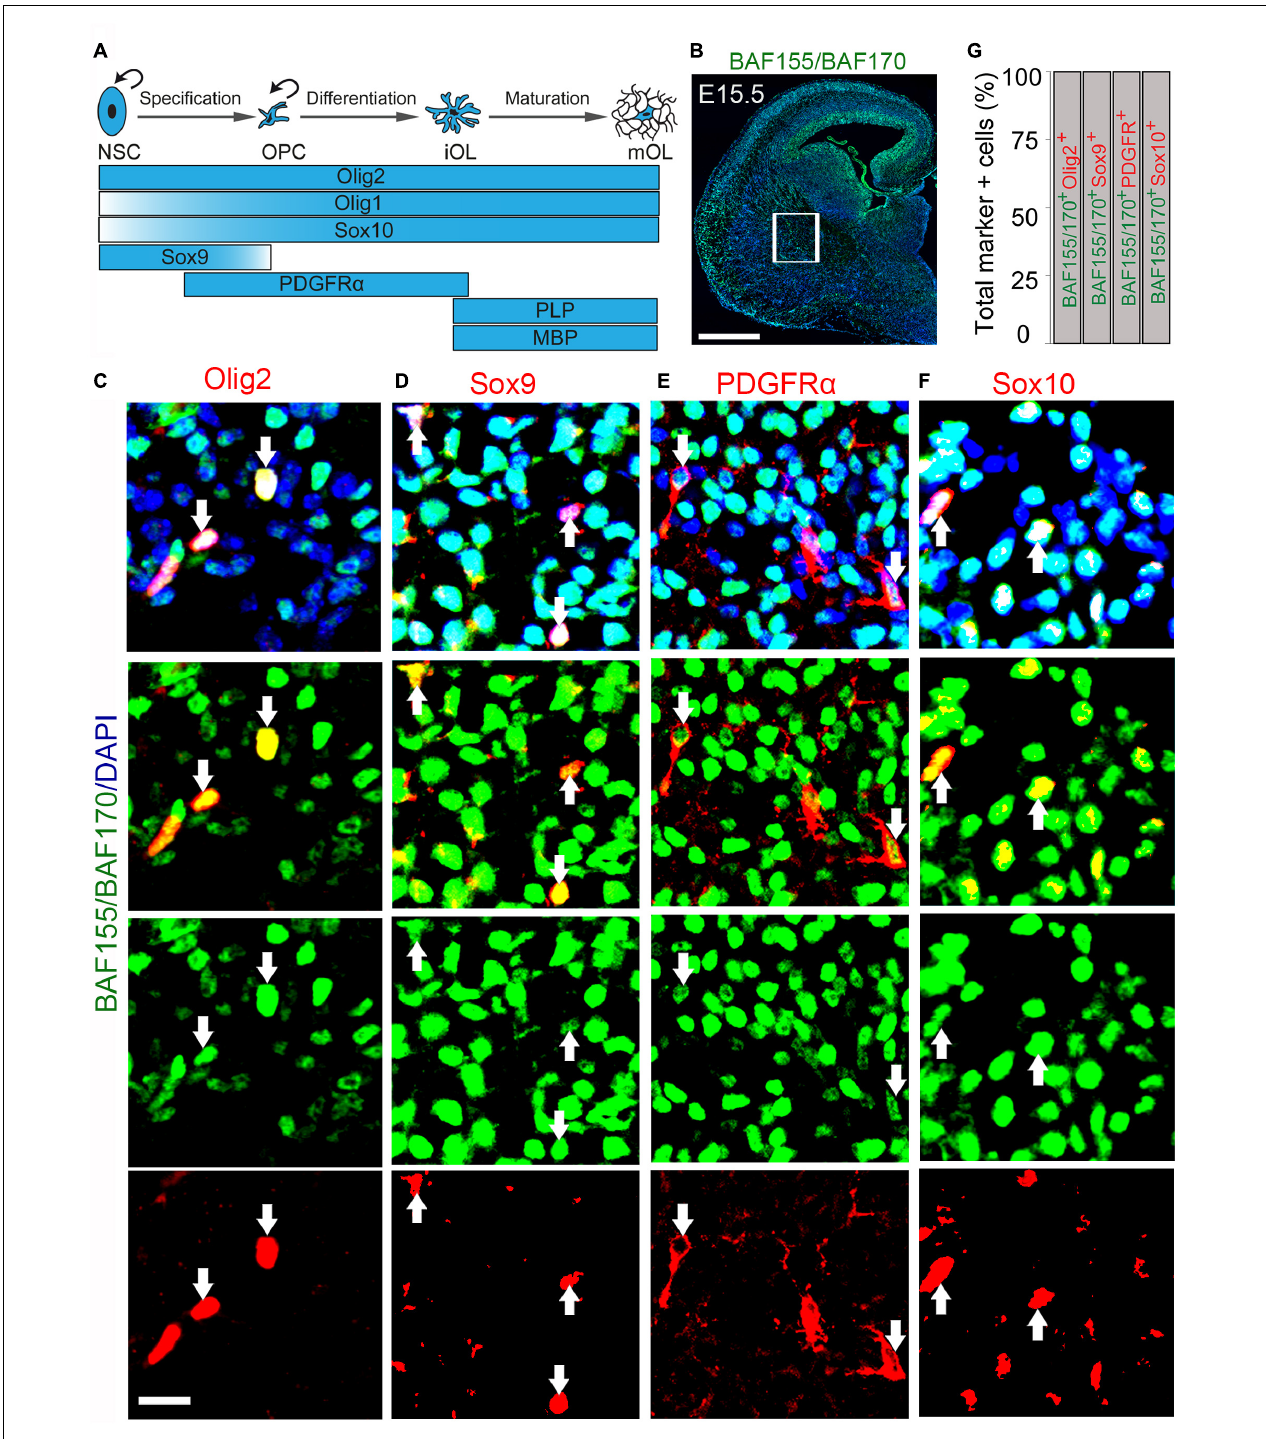
FIGURE 2 | BAF155 and BAF170 expression in the oligodendroglial lineage in the ventral telencephalon. (A) Diagram illustrating the stepwise oligodendrocyte lineage progression and the expression pattern of key molecular drivers. Curved arrows denote proliferation. (B–F) Micrographs showing BAF155 and BAF170 expression (B) alongside the oligodendrocyte lineage markers Olig2, Sox10 for pan-oligodendrocyte (C,F) , Sox9 for glioblasts (D) , and PDGFR α for OPCs (E) in coronal sections of the mouse forebrain at E15.5 using immunohistochemistry. (G) Bar graph showing quantitative estimation of proportion of Olig2, Sox9, PDGFR α , and Sox10 positive cells with BAF155 and BAF170 expression. Inserted box shows selected area for quantification. Arrows refer to the oligodendrocytic lineage expressing BAF155 and BAF170. Experimental replicates ( n ) = 3. NSC, neural stem cell; OPC, oligodendrocyte precursor cell; iOL, immature oligodendrocyte, mOL, mature oligodendrocyte. Scale bars = 200 µ m (B) , 25 µ m (C) , 50 µ m (D–F) .